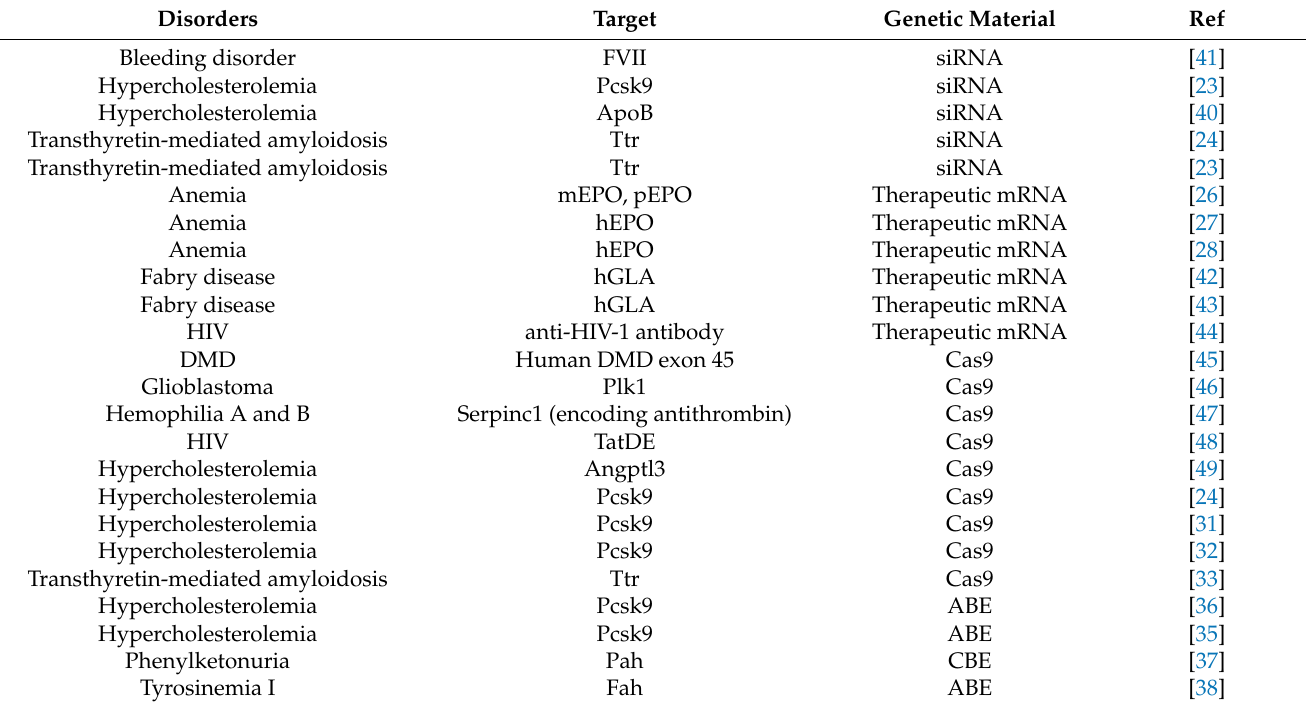
Table 4. LNP-based preclinical